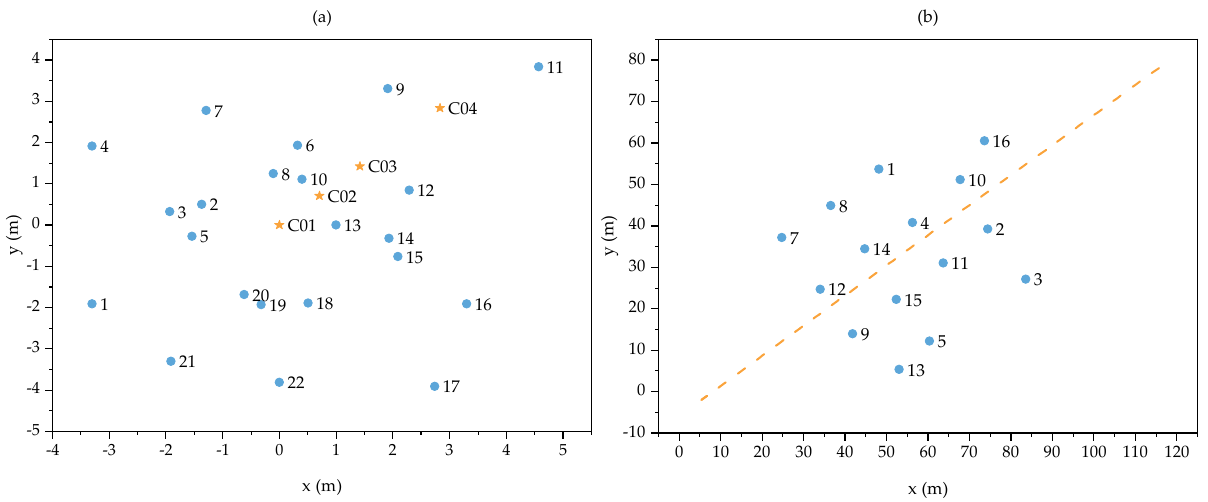
Figure 7. ( a ) Diagram illustrating the IRSS LSI_C indoor dataset. The blue circles indicate the locations of twenty-two 5.08 × 5.08 cm cylindrical NaI(Tl) detectors, with orange markers showing the positions of a 281 kBq 137 Cs source in experiments LSI_C01, LSI_C02, LSI_C03 and LSI_C04 [71]. ( b ) Schematic of the IRSS C11 outdoor dataset experimental setup, with the blue circles indicating the locations of sixteen 5.08 × 5.08 cm cylindrical NaI(Tl) detectors and the orange line defining the trajectory of a 6.5 MBq 137 Cs source